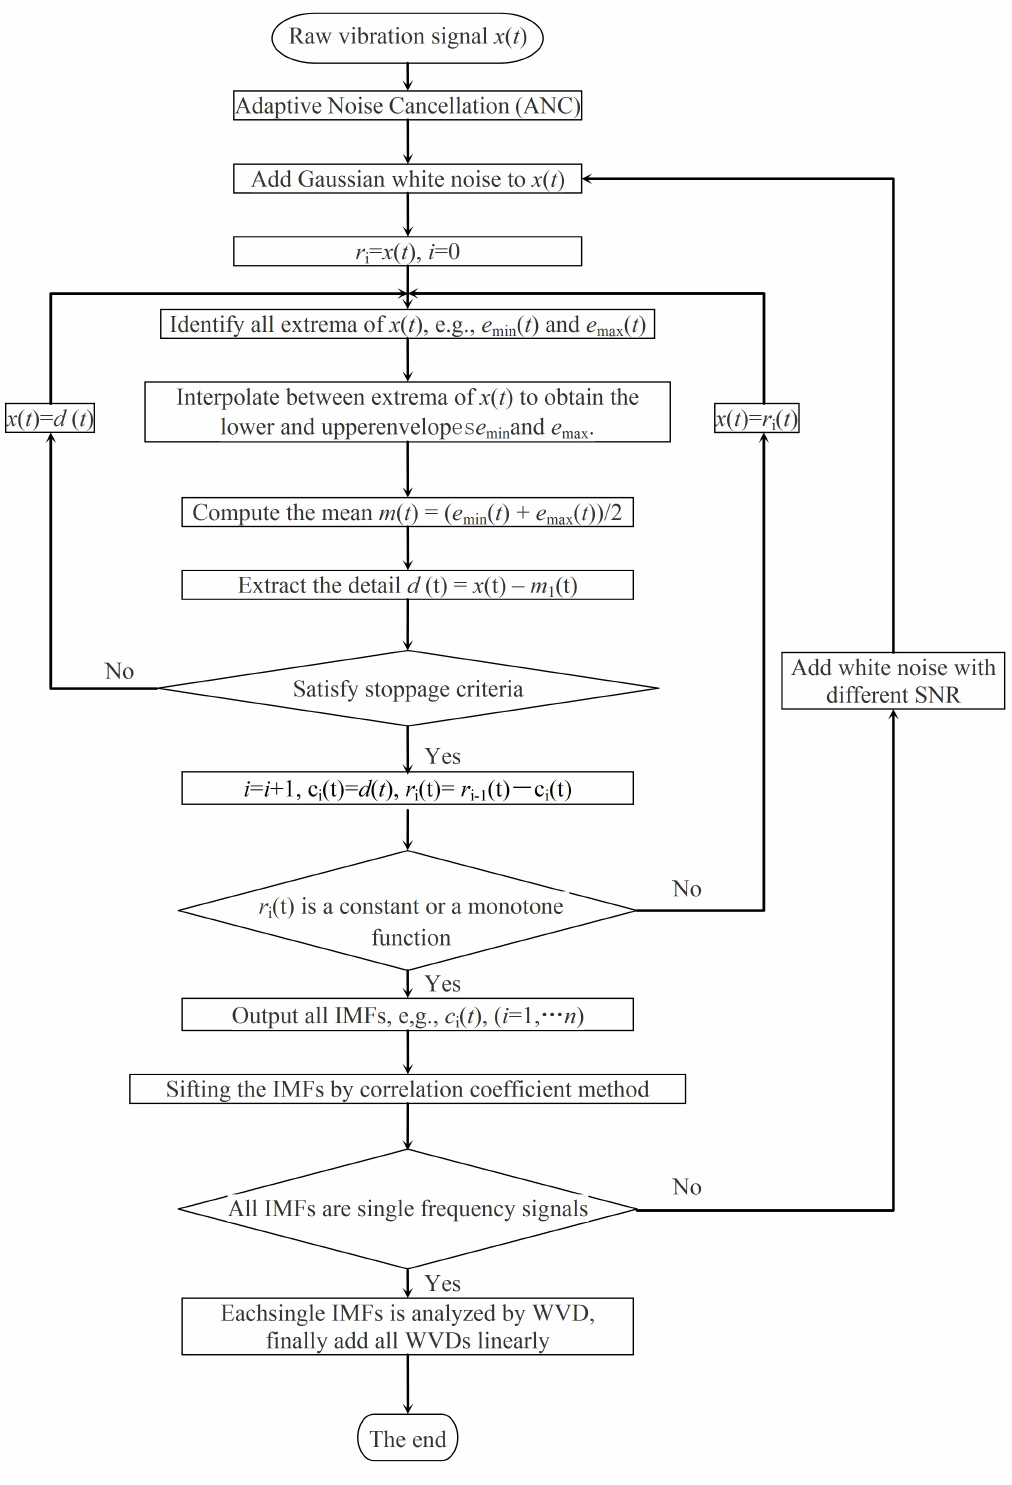
Figure 3. Flow chart showing algorithm for joint time-frequency analysis based on Ensemble Empirical Mode Decomposition (EEMD) and Wigner-Ville distribution